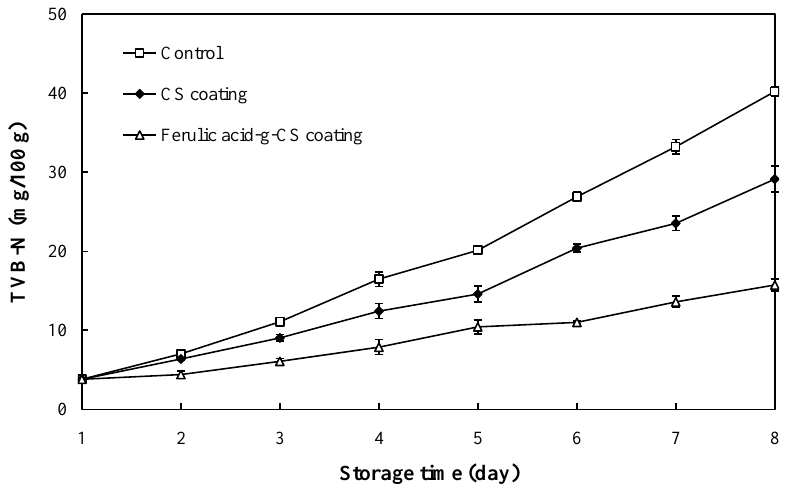
Figure 2. Changes in the TVB-N value of pork in the control group, CS coating group and ferulic acid-g-CS coating group at 4 °C for 8 days. Data are presented as means ± SD of triplicates.